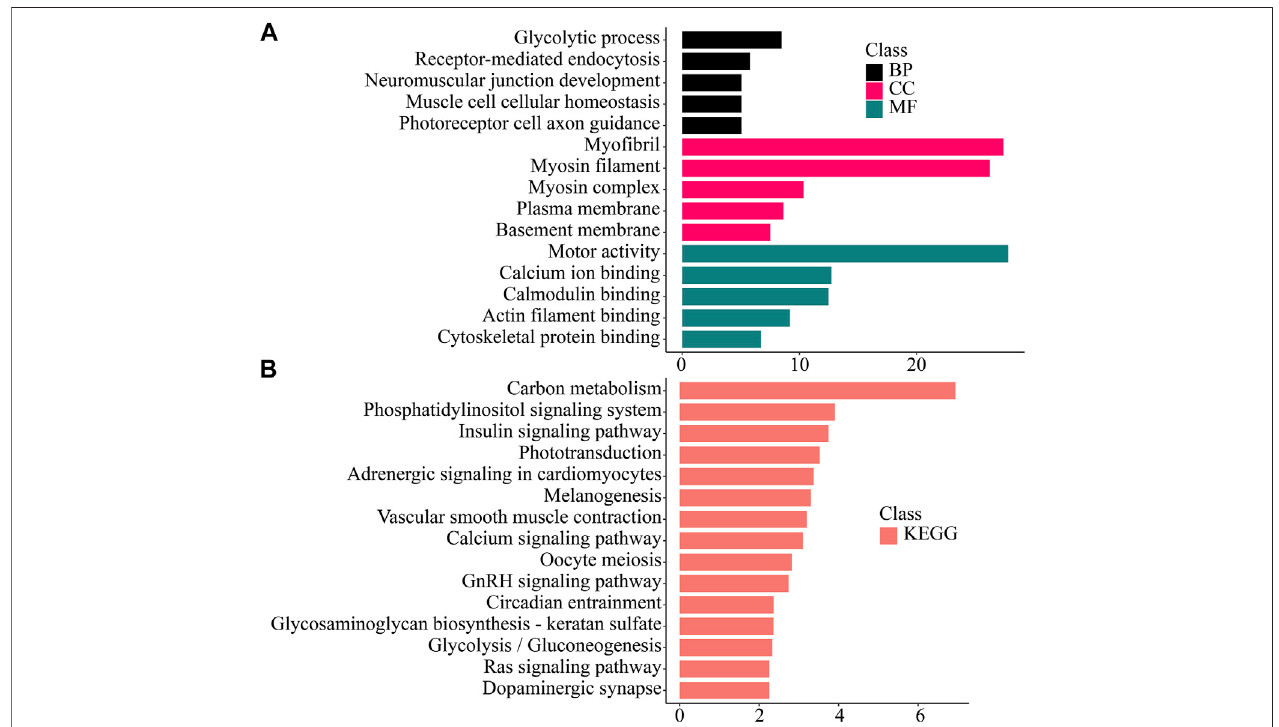
FIGURE 6 | Enrichment analysis of Muscle -speci fi c differentially expressed genes. (A) GO enrichment. BP: Biological process. CC: Cellular component. MF: Molecular function. (B) KEGG enrichment. KEGG: Kyoto Encyclopedia of Genes and Genomes; GO: Gene Ontology.